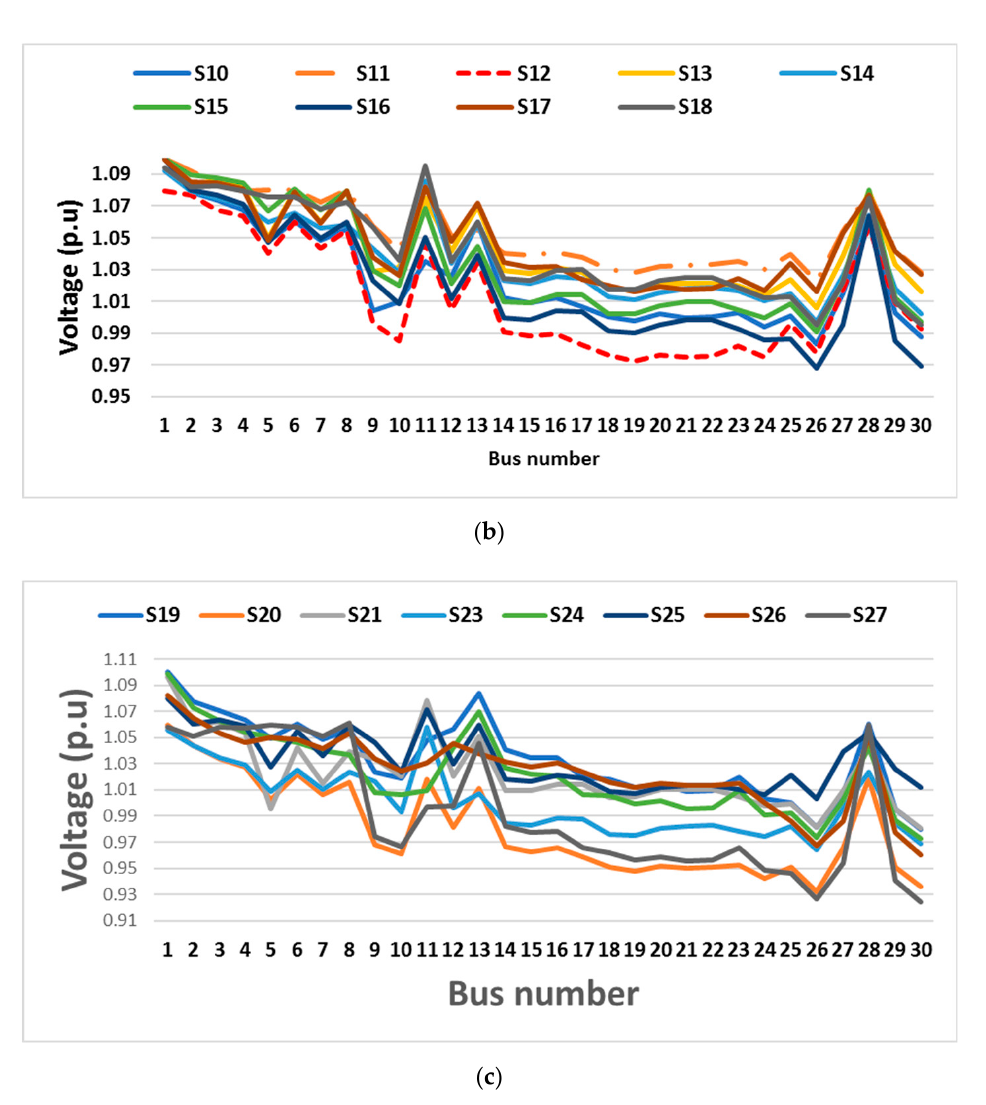
Figure 6. The system voltage profile for ( a ) Scenarios 1 to 9, ( b ) Scenarios 10 to 18 and ( c ) Scenarios 19 to 27.